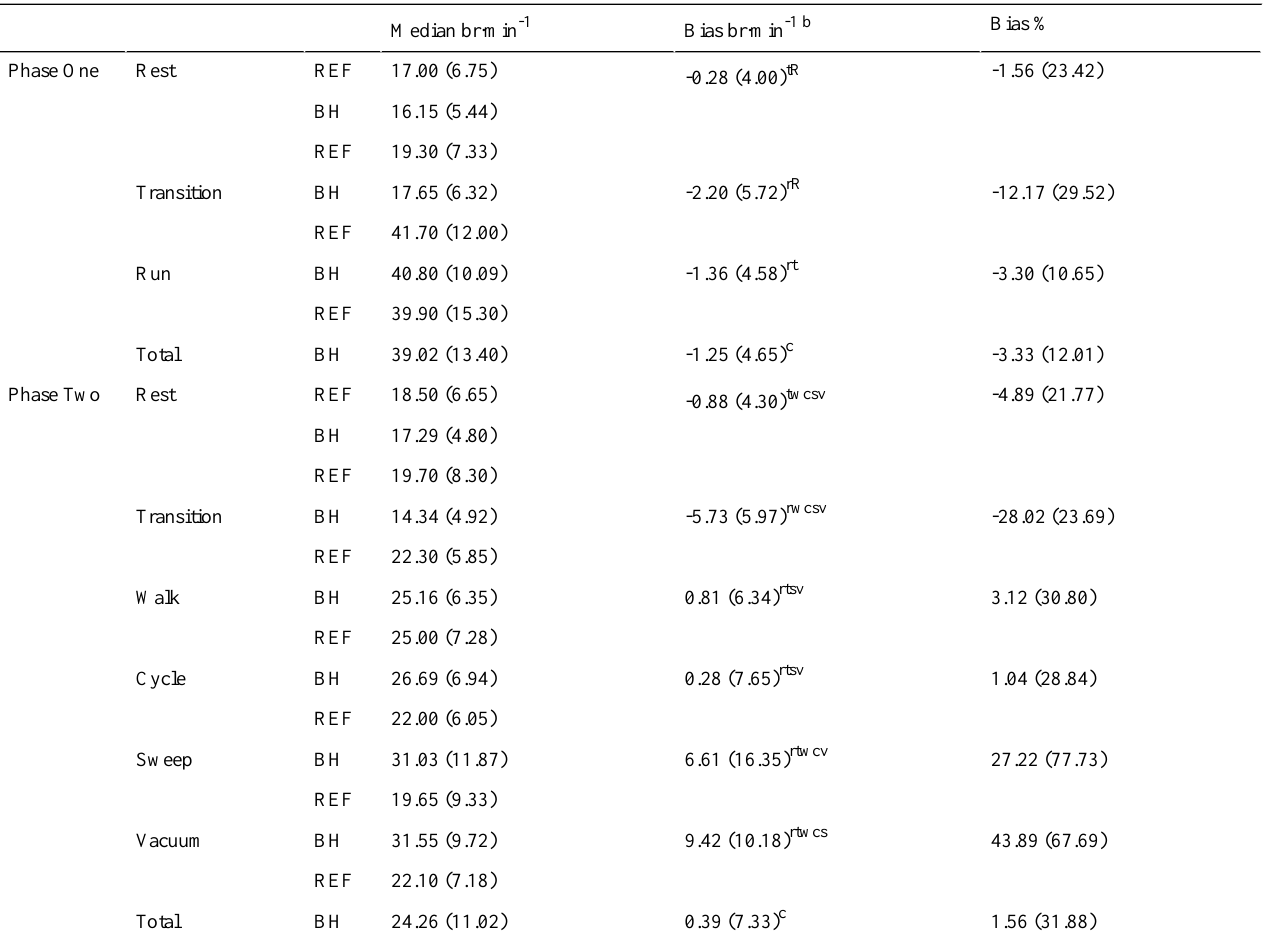
Table 3. Biases between BioHarness and reference respiratory rate (Phase One: participants in sinus rhythm; Phase Two participants with atrial fibrillation) a